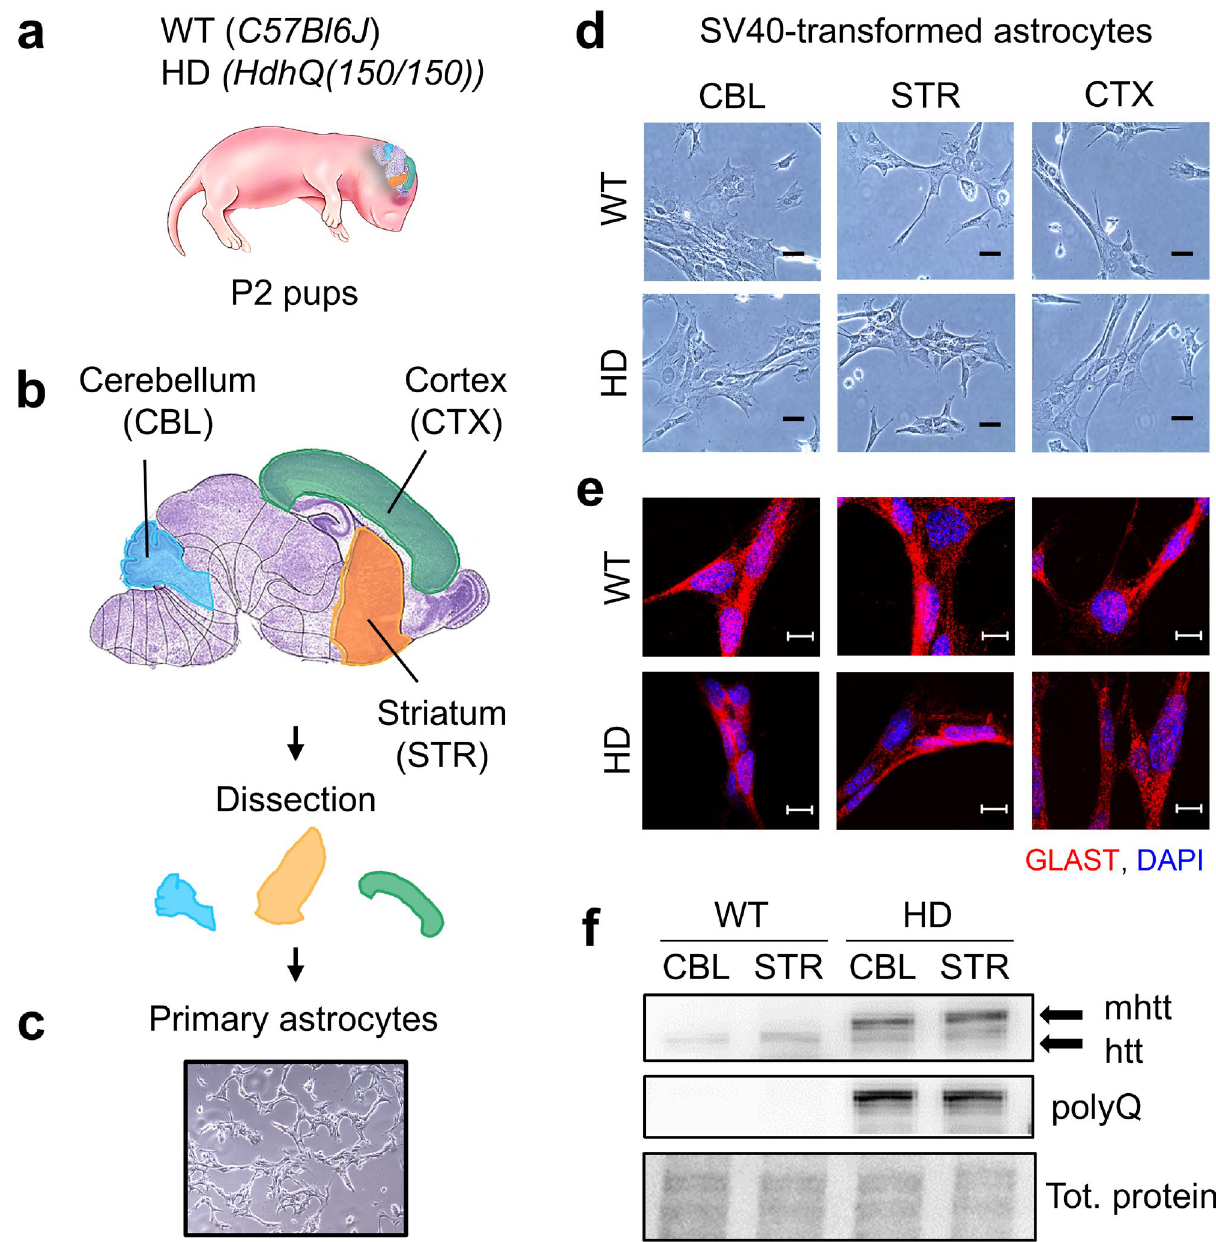
Figure 3. Astrocyte cultures from WT and HD animals are visually indistinguishable. ( a ) Astrocyte cell lines from CBL, STR, CTX were dissociated and isolated from the brains of postnatal (P2) mice, from either WT or HD mice. ( b ) Cartoon adapted from the Allen Reference Atlas for the developing mouse brain at P4 and the dissected regions used in the analysis. The regions are schematically illustrated is the Nissl-stained brain image (purple) from P4 animals. ( c ) A representative brightfield image of primary astrocytes from the cortex of WT mice. ( d ) Purified SV40T astrocytes in all 3 brain regions from WT and HD mice. Scale bars = 20 µm. ( e ) Transformed cultures were stained for Glutamate Aspartate Transporter 1 (GLAST1) antibody marker to confirm their identity as astrocytes, as well as stained with DAPI to define the nucleus. Scale bars = 20 µm. Cell lines of either genotype have similar morphology. ( f ) Western blot analysis showing that mouse astrocytes from WT and HD mice express normal htt and the mutant (mhtt), respectively, in the STR and CBL. HD astrocytes alone express mhtt, which includes an expanded polyQ stretch. The loading control is total protein visualized with No-Stain Protein Labelling Reagent. The uncropped images are shown in Supplemental Fig.